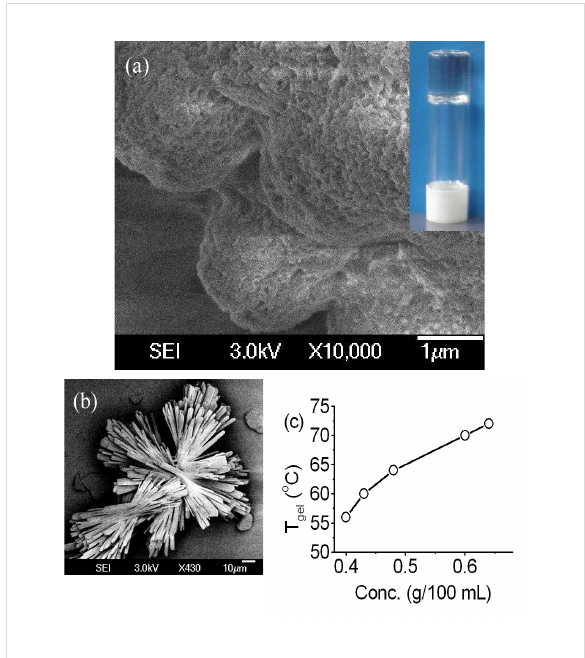
Figure 2: Scanning electron micrographs of the dried gels of compound 3 in mesitylene (a, inset: inverted vial containing a gel in mesitylene) and o -xylene (b). (c) Plot of T gel vs conc. (g/100 mL) in o -xylene.